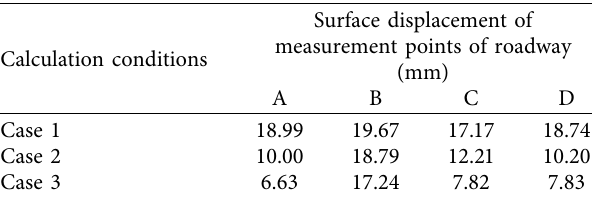
Figure 7: Surface measurement points arrangement of the roadway. Table 2: Surface displacement of monitoring points of the roadway under different